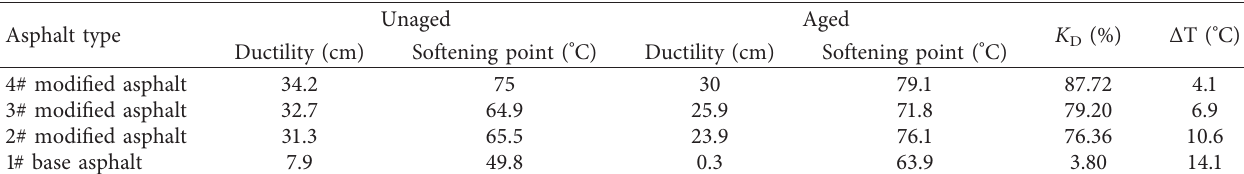
Table 8: Test results of base asphalt and modified asphalt before and after UV ageing.